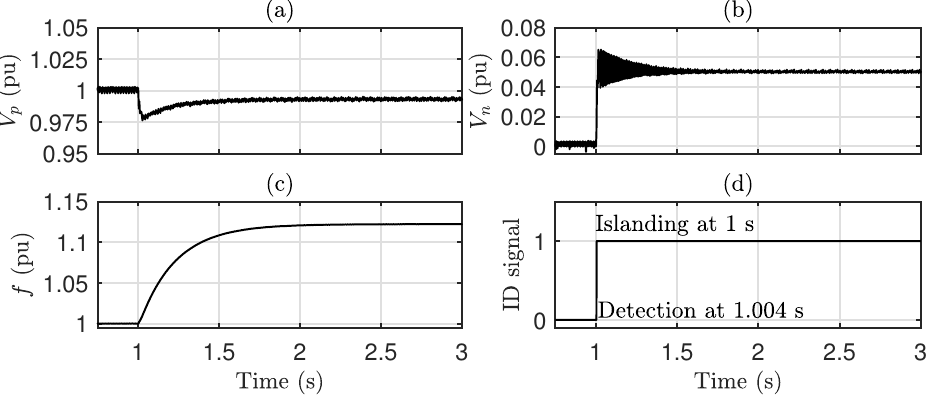
Figure 13. LCL -type filter case. Performance under load ( L ) imbalance: ( a , b ) estimated magnitudes of positive- and negative-sequence PCC voltage, respectively; ( c ) estimated frequency; and ( d ) ID